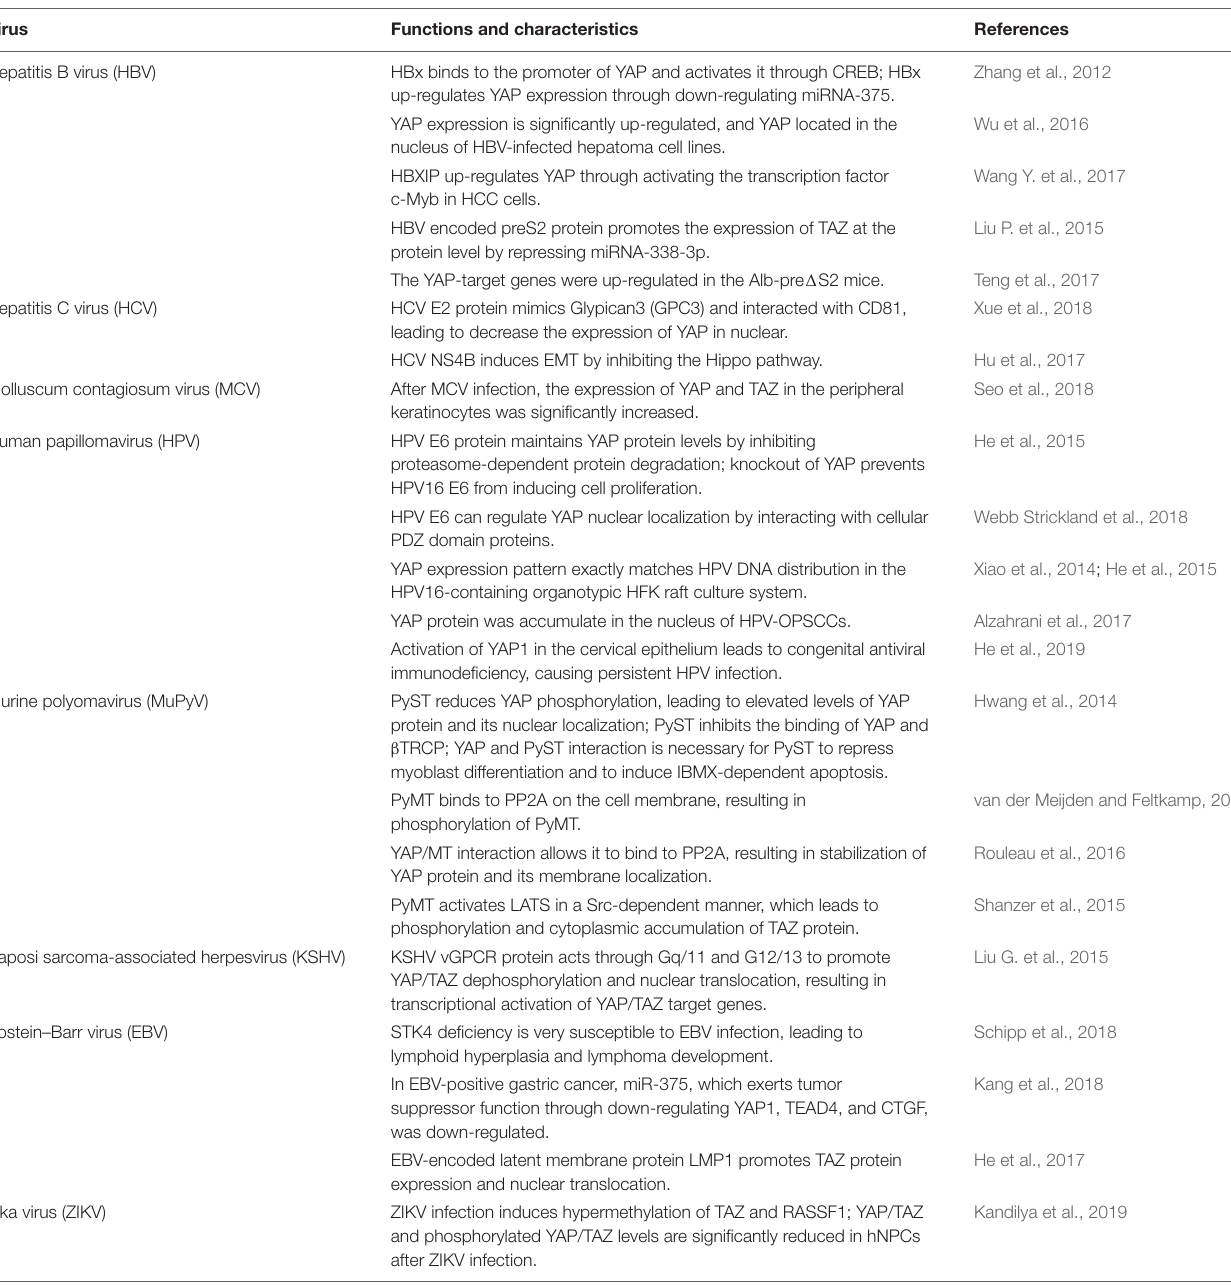
TABLE 1 | Functions of the Hippo pathway in viral